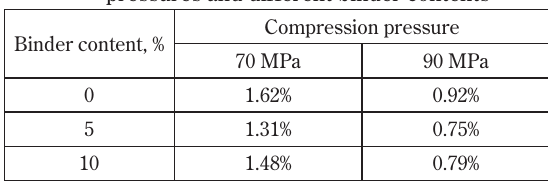
Table 6 Friability (%) of tablets made from dry powder formulations at 70 and 90 MPa compression